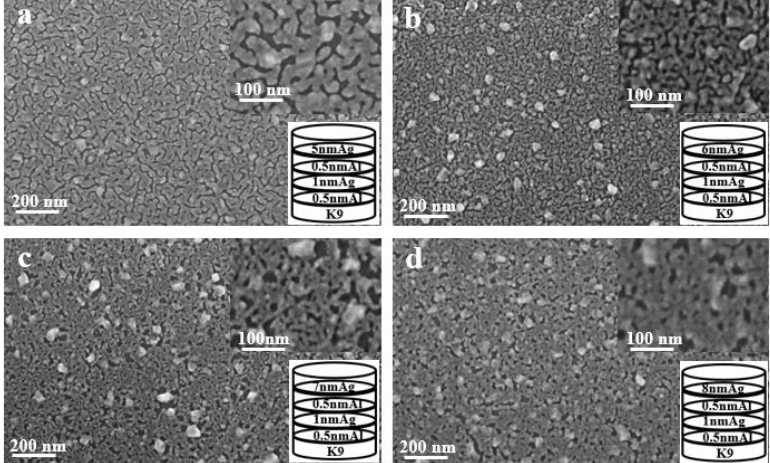
Figure 10. SEM images of alternating deposition of aluminum seed layer and silver film ( a – d ).